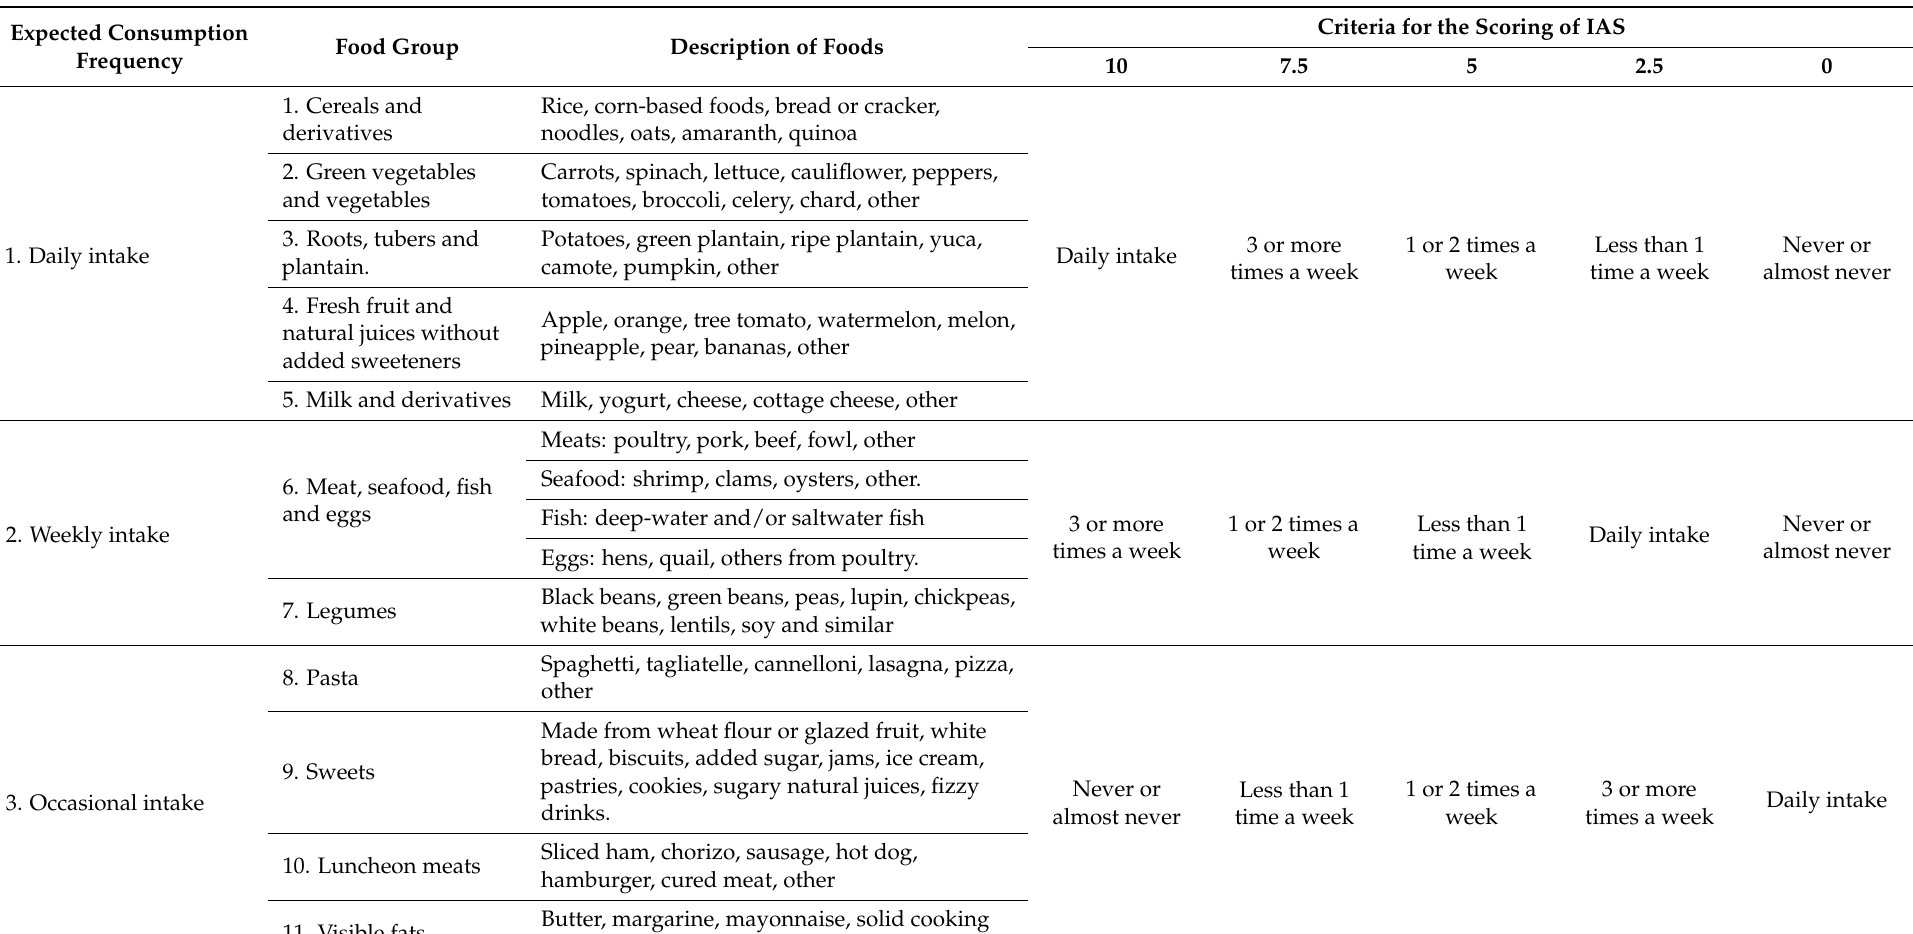
Table 1. Recommendations for the frequency of consumption of determined foods according to dietary groups, dietary components, and score used to determine the healthy eating index